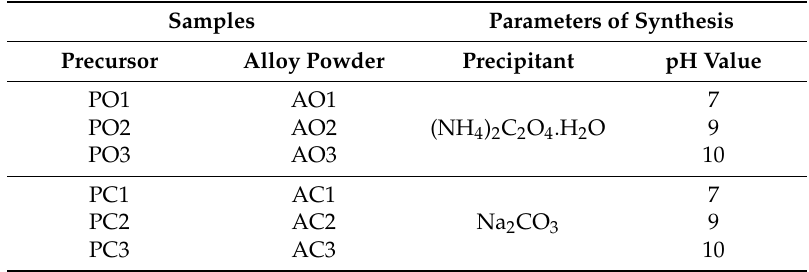
Table 1. Synthesis conditions and names of